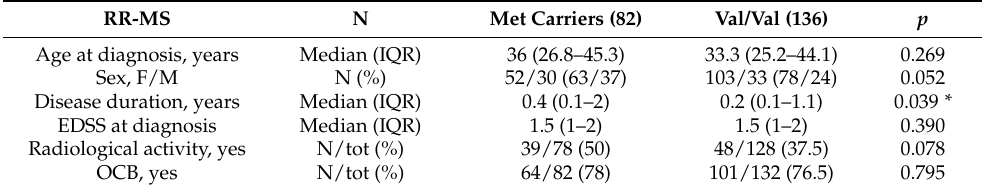
Table 1 Legend: expanded disability status scale (EDSS); female (F); interquartile range (IQR); male (M); mul- tiple sclerosis (MS); number (N); oligoclonal bands (OCB); Relapsing–remitting (RR). (*) denotes